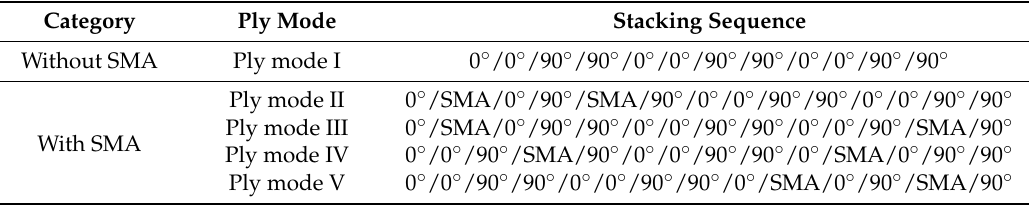
Table 3. The exact locations of the embedded SMA fibers in composites.